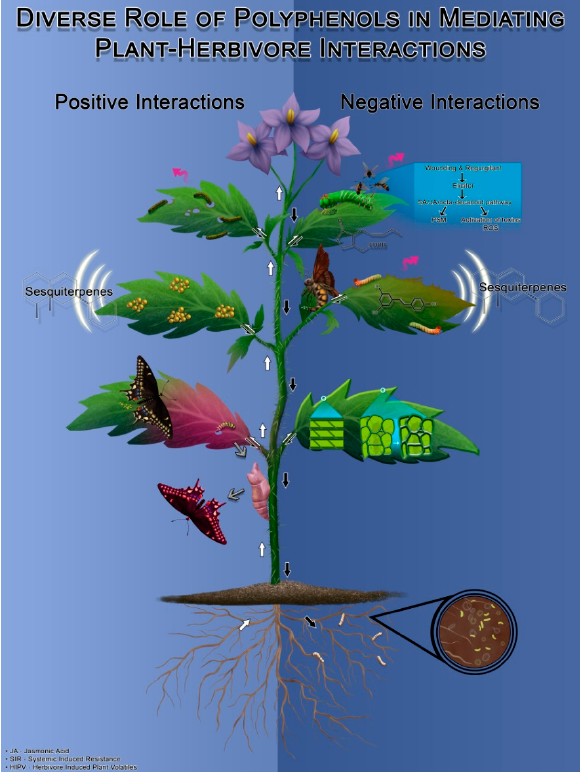
Figure 4. Schematic illustrating the wide gamut of herbivory related functions performed by polyphenols in plants. Plants produce polyphenols at the advent of adverse conditions such as biotic and abiotic stresses. Herbivory causes abrasions, wounds, and tissue loss which act as signal for the production of polyphenols. Moreover, the saliva or regurgitant from herbivores contain peroxidases which act as elicitors for the activation of different signaling pathways [112]. These secretions ac- tivate different plant hormones and signaling pathways such as jasmonic acid, salicylic acid and octadecanoid pathway [128] which generate and transmit signals to all the parts of plants which is depicted by bi-directional arrows running throughout the plant leading to generation of Systemic Induced Resistance (SIR) in the plants [148]. The production of polyphenols also leads to synthesis of sesquiterpenes for defense priming of the neighboring plants. Both positive and negative impacts are being illustrated on the plant with left and right sides of the schematic respectively. Polyphenols generally have anti-feedent and anti-deterrent effect on most of the insects. Flavonoids (class of polyphenols) and tannins have cascading effects on the feeding and oviposition activity of tobacco hornworm caterpillar [ Manduca sexta L.; [8,22], also protects plants against the damaging herbivores by releasing herbivore-induced plant volatiles (HIPV) attracting their predators and parasitoids [149]. Activation of defense mechanisms also leads to the production of reactive oxygen species (ROS) which ultimately lead to the formation of polyphenol oxidase and subsequent synthesis of compounds such as proteinase inhibitors preventing the digestibility of tissues by cross-linking and polymerizing the cells walls with alkylated amino acids. Polymerization of cinnamyl alcohol into lignin by polyphenol oxidase (formed due to activation and synthesis of polyphenols) deposits lignin in leaves and fruits which also confers resistance to the plants [150]. These chemical toxins are also observed to have negative impacts on activity and functionality of microbes, thus indirectly affecting their symbiotic insects as well [151]. Polyphenols are also observed to affect the herbivores positively; thus, playing dual role in plant-insect relationship dynamics. Flavanone glycosides present in carrot ( Daucus carota L.; Apiaceae) acts as oviposition stimulant for black swallowtail butterfly ( Papilio polyxenes Fabricius) by releasing volatiles which attract the insects to lay eggs [145], and sequestration of flavone gluco- sides in the wings of lycaenid butterfly ( Polyommatus bellargus Rottemburg) aiding them in visual communication and mate recognition. Illustration by Annette Diaz, conceptualized by Ishveen Kaur and Japneet